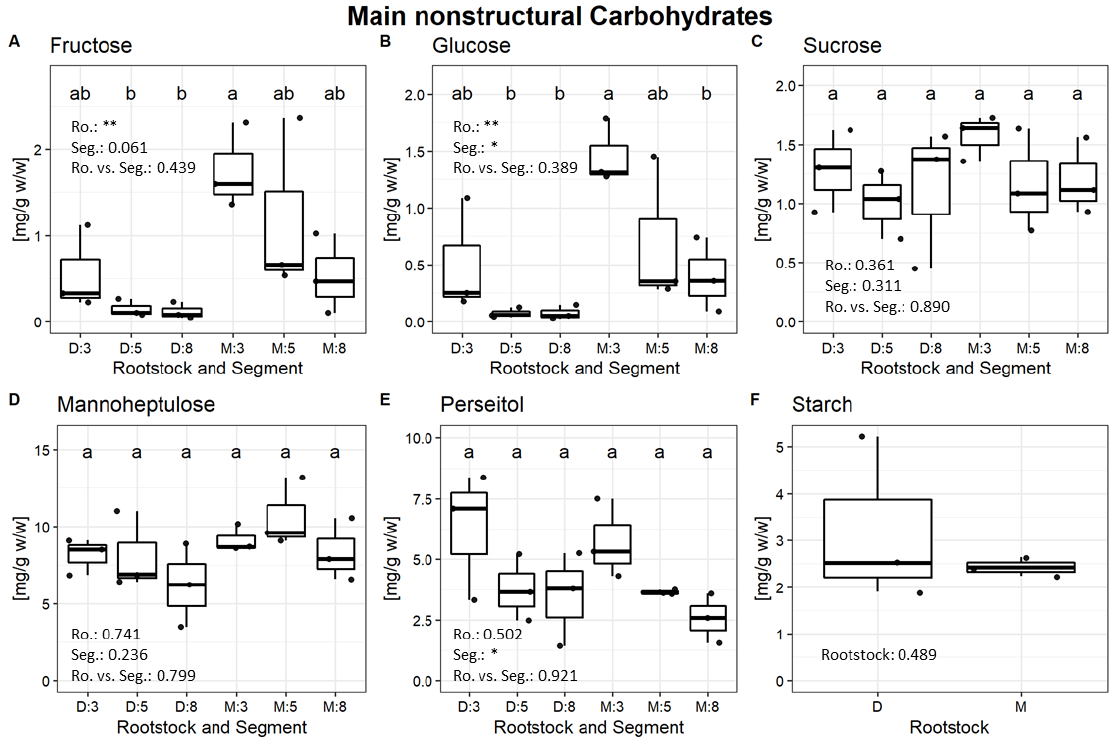
Figure 2. Main nonstructural carbohydrates (Fructose (A), Glucose (B), Sucrose (C),Mannoheptulose (D), Perseitol (E) and Starch (F)) plotted with a boxplot and results of a Tukey HSD test. Text are p values of the two-way ANOVA test ( p < 0.05 (*), <0.01 (**), <0.001 (***)). “Dusa” (D) and “Mexicola” (M) rootstock and root segments (3, 5 and 8 cm). Due to sample limitation, for starch quantification, root segments were